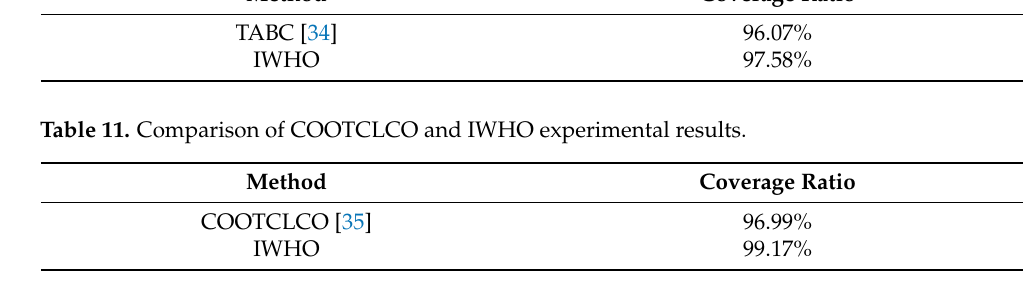
Table 11. Comparison of COOTCLCO and IWHO experimental results. Method